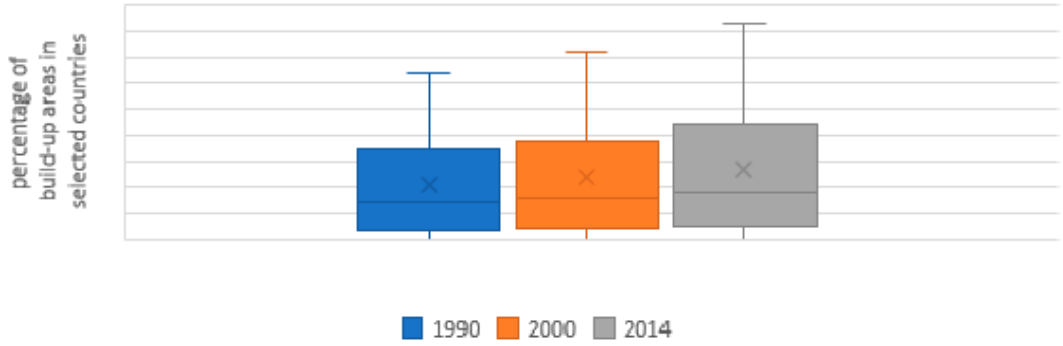
Figure 1. Average percentage increase in developed surface area between 1990 and 2014 in the 40 most developed countries of the world. Source: own study [10] .